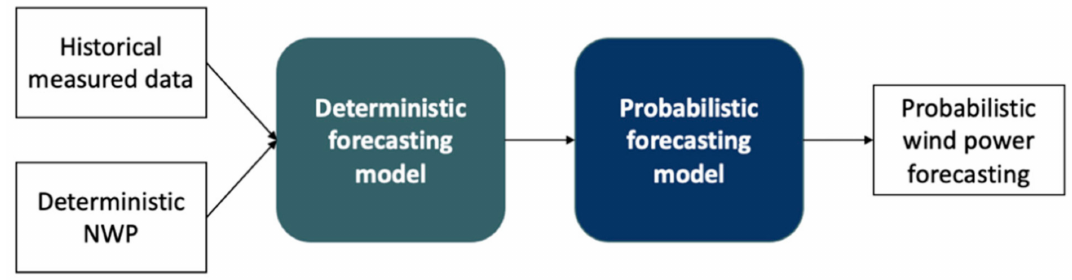
Figure 1. Schematic diagram of probabilistic approaches based on deterministic Numerical Weather Prediction